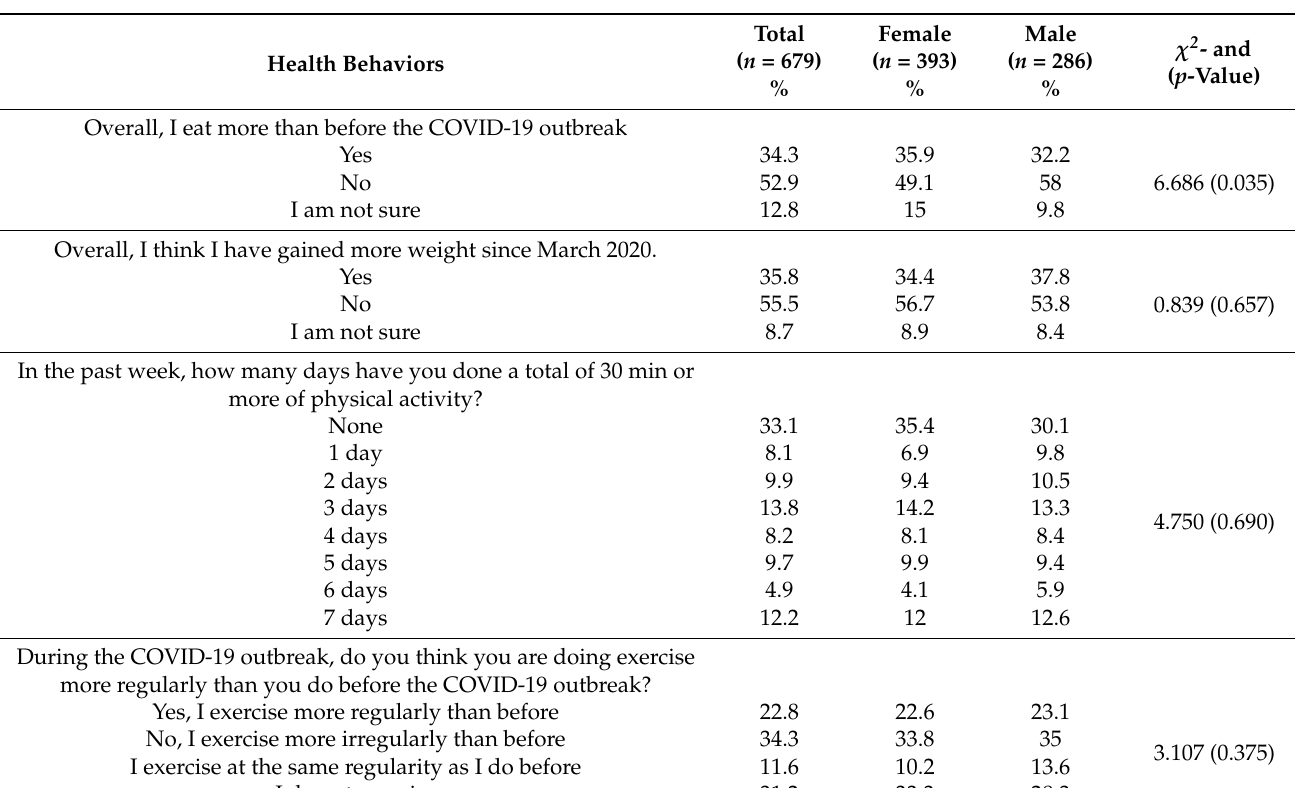
Table 2. Health behaviors during the COVID-19